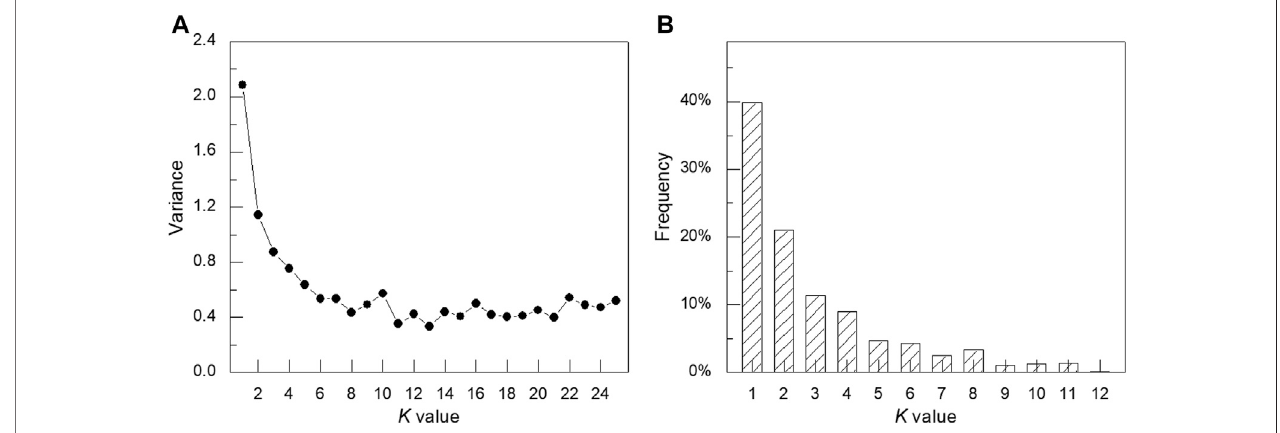
FIGURE 9 | (A) Sum of square error of different cluster numbers. (B) Experiments for the cluster number of 10.